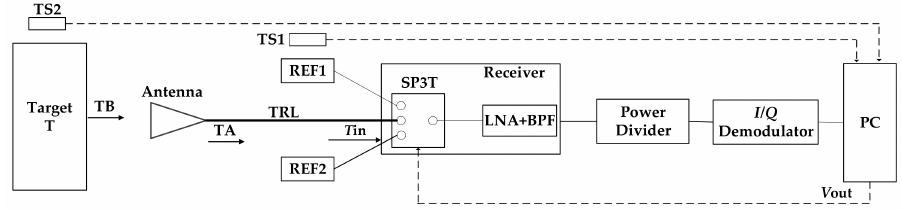
Figure 22. Schematic diagram of interferometric microwave radiometer with double reference